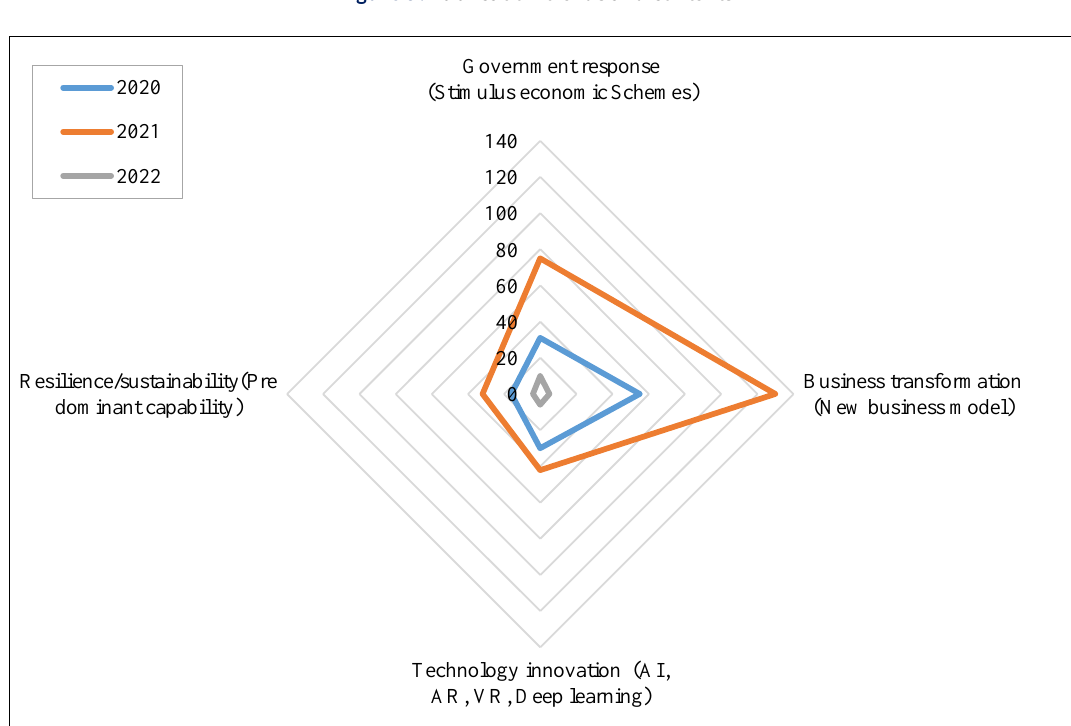
Figure 4. Comparison trending publications related to intention of application adoption by